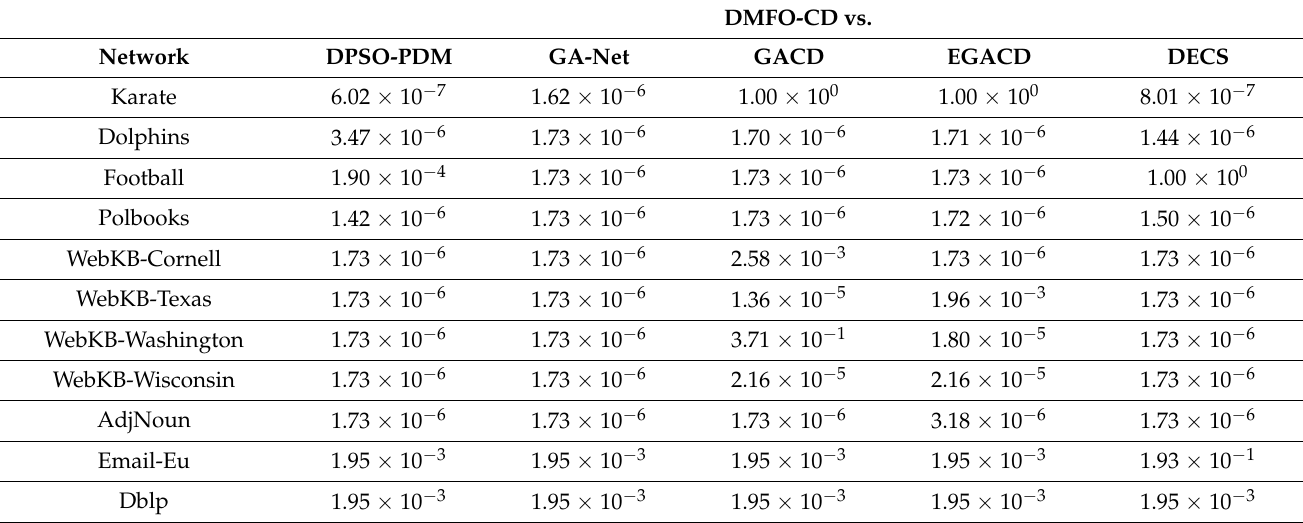
Table 6. The p values of Wilcoxon signed-rank